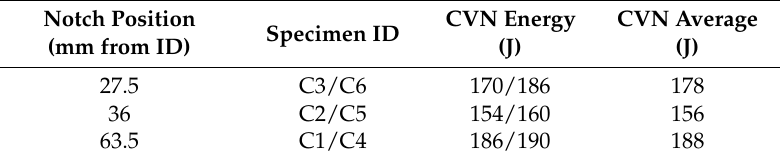
Table 4. Results from CVN-C impact test